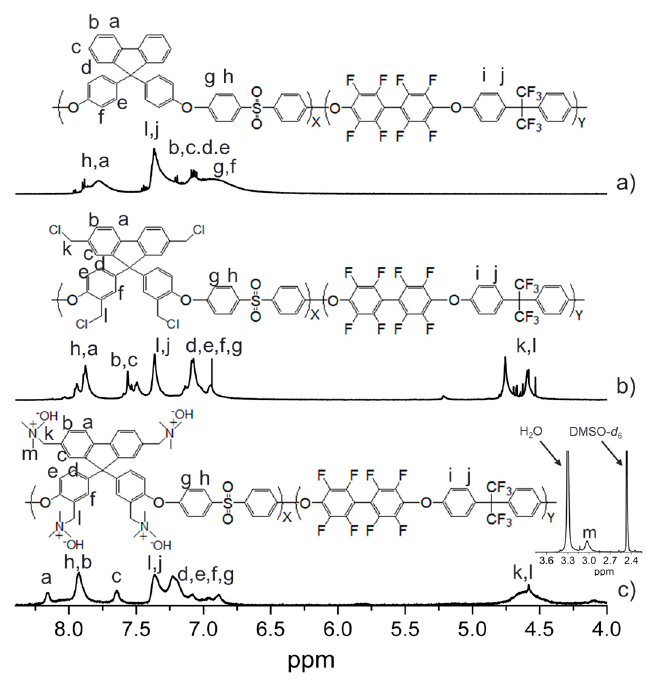
Figure 3. 1 H NMR of ( a ) PAES X10Y13, ( b ) CM-PAES X10Y13, and ( c ) QN-PAES